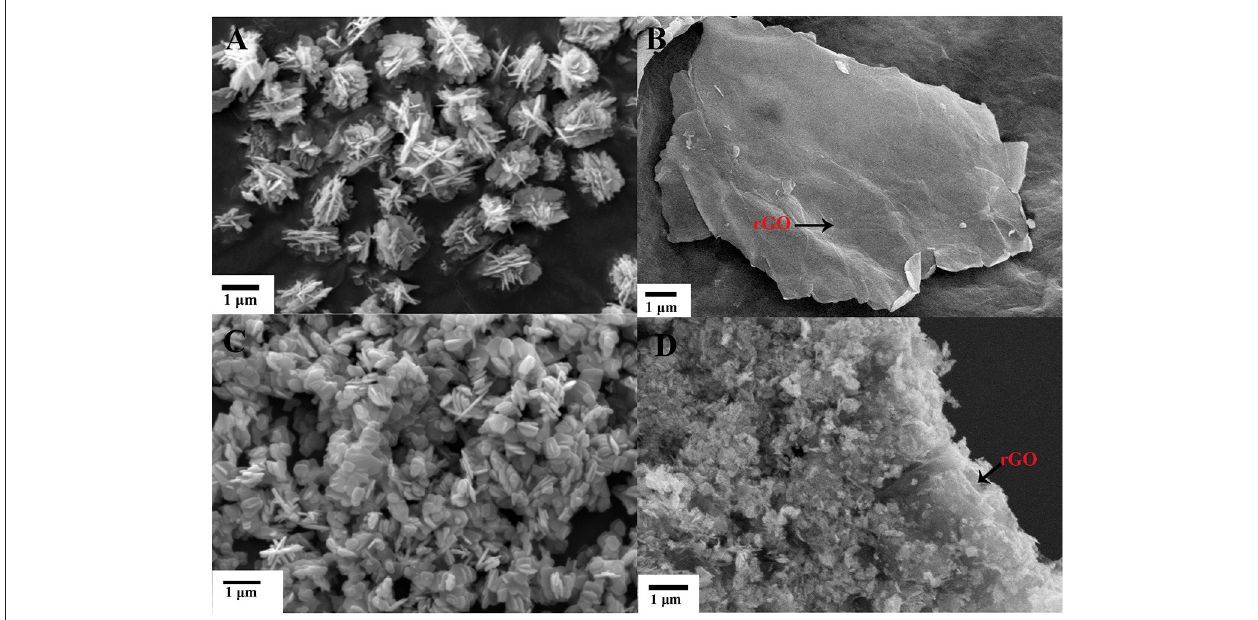
FIGURE 1 | SEM images of (A) ZnO, (B) GO, (C) Cu/ZnO, and (D) Cu/ZnO/rGO nanocomposite.